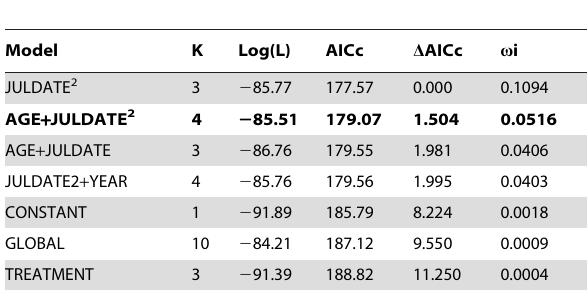
Table 1. The top logistic exposure models of daily survival rate of Ovenbird nests in Algonquin Provincial Park in 2008 and 2009 as chosen using AIC model selection corrected for small sample size (AICc).